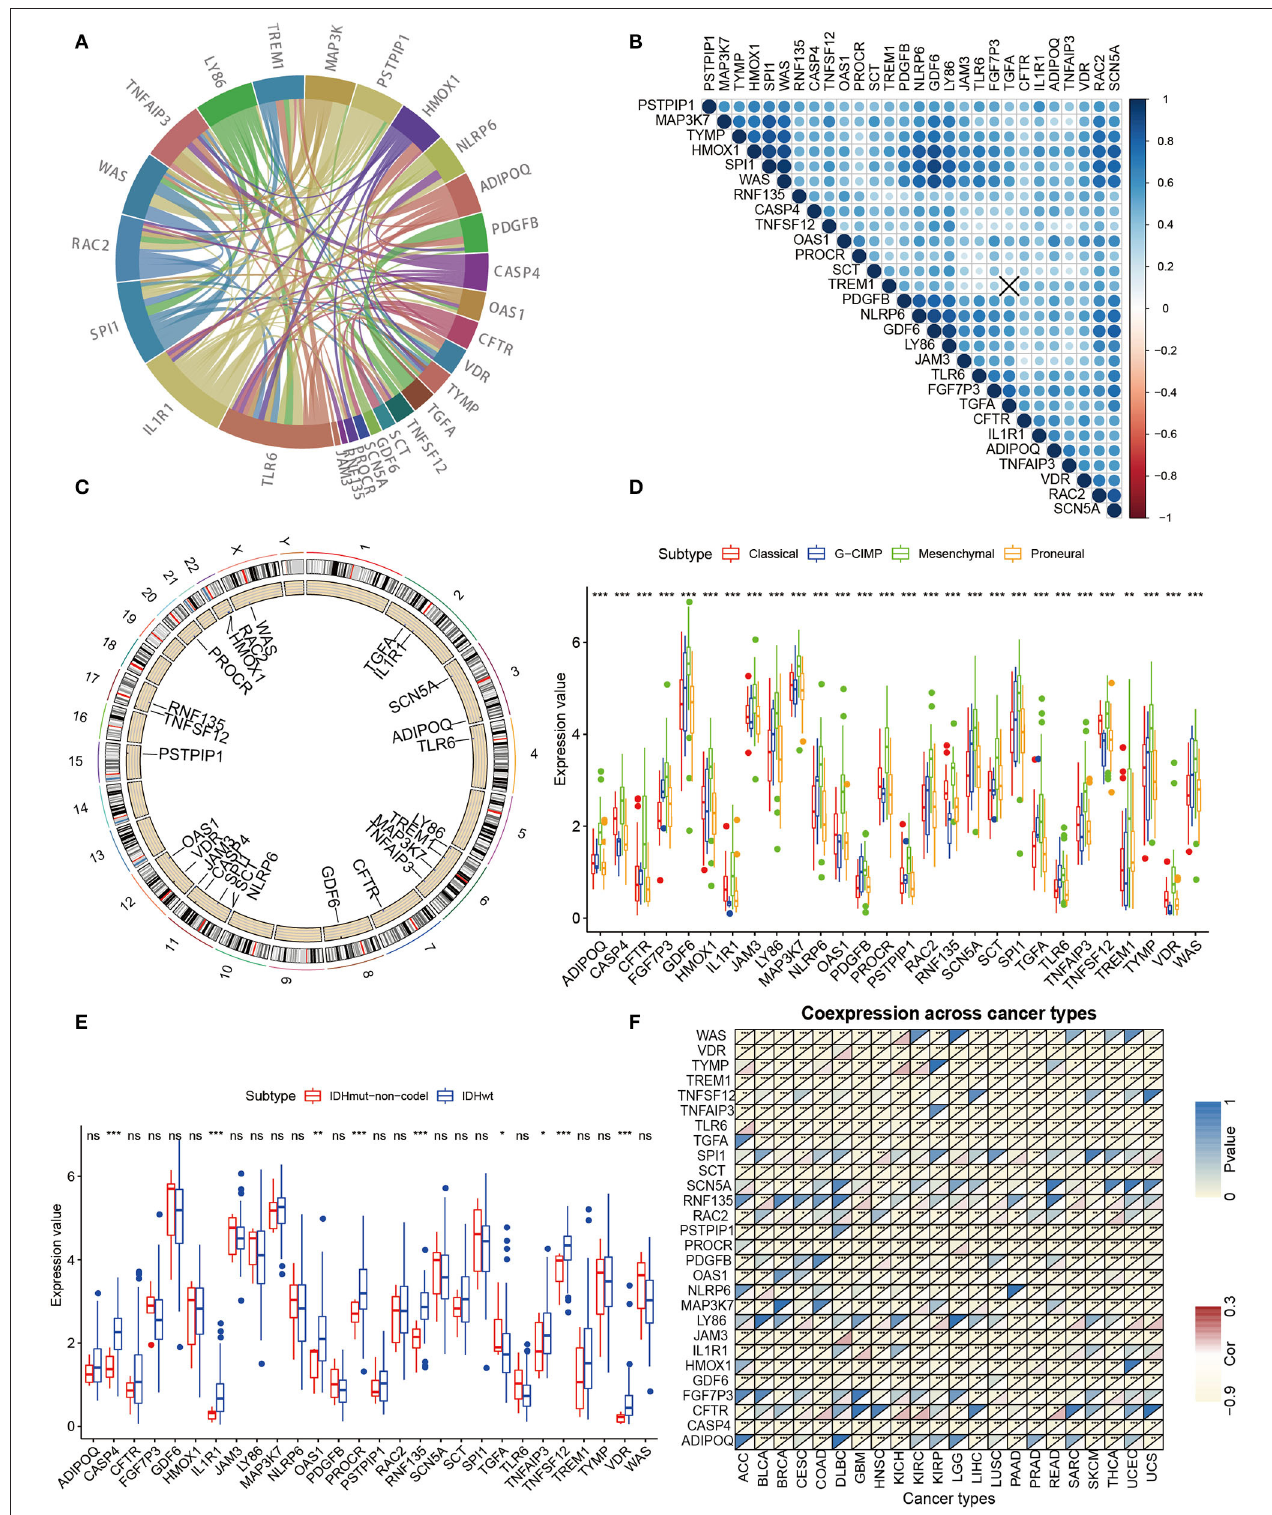
FIGURE 3 | Further analysis of clinicopathologic characteristics of 28 hub genes. (A) PPI analysis was performed among the 28 hub genes. (B) Spearman relevance analysis of the 28 hub genes. (C) Circle maps of disparity CNV of pivotal genes. The black dots outside the circle represent amplification, while the red dots inside the circle represent deletion. (D) Expression of 28 hub genes in GBM molecular typing. (E) Differential expression of hub genes in GBM IDH typing is evident for all 28 genes. (F) Correlation of the expression value of hub genes and Immunescore for pan-cancer (Pearson test).